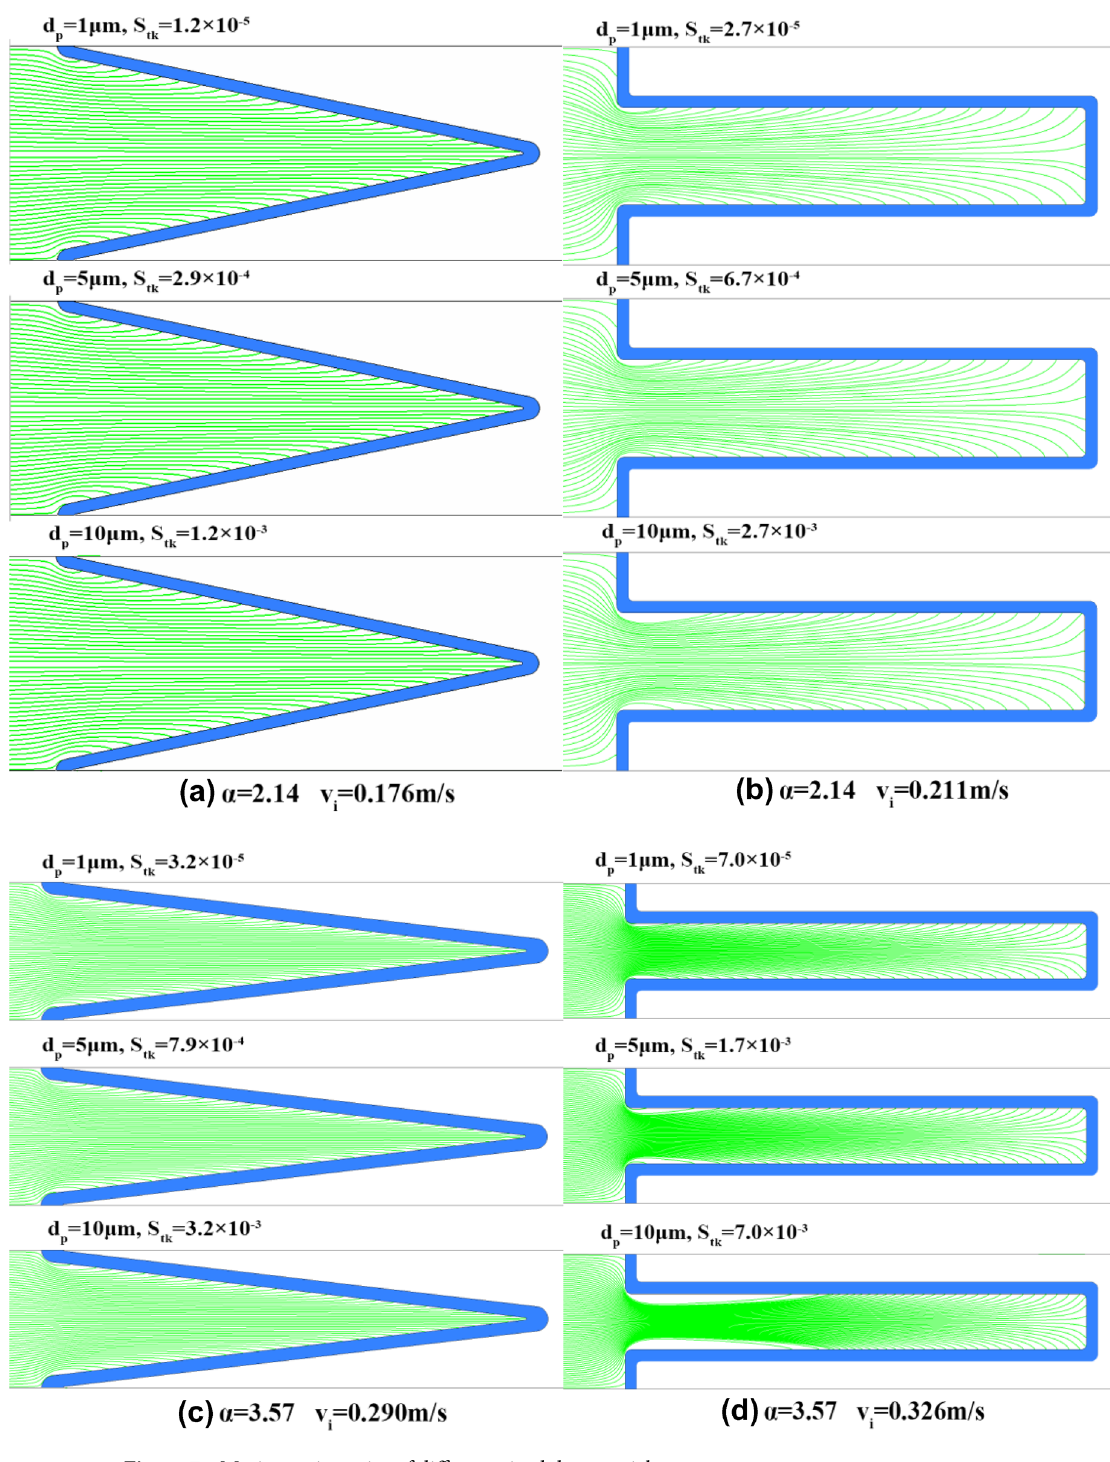
Figure 7. Motion trajectories of different-sized dust